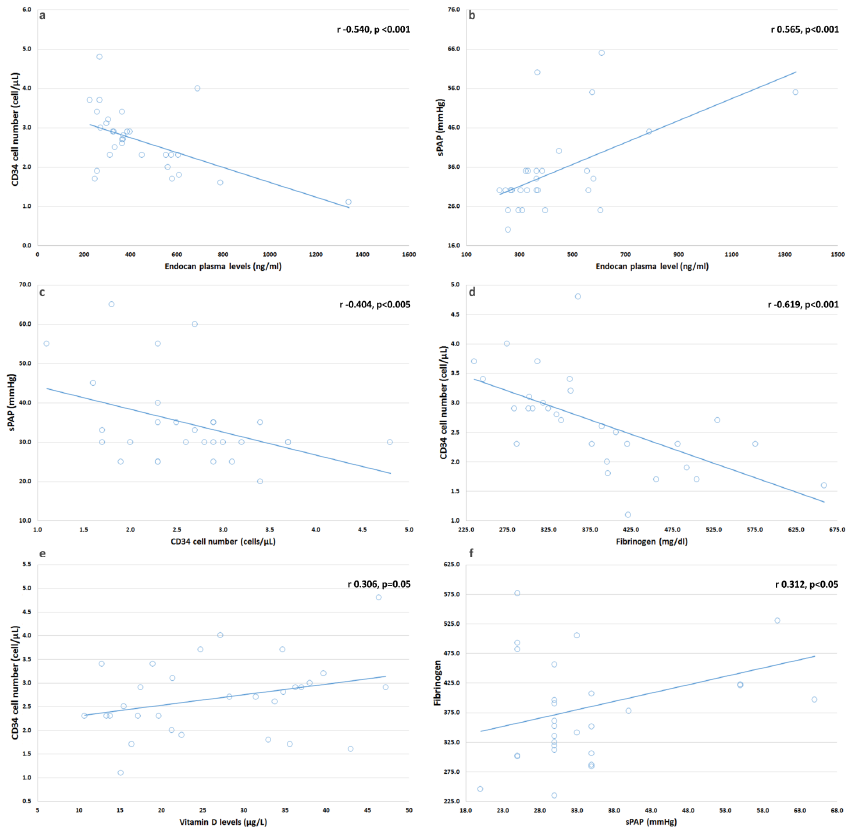
Figure 2. Spearman’s correlation between CD34+ and endocan ( a ); sPAP and endocan ( b ); sPAP and CD34+ ( c ); CD34+ and fibrinogen ( d ); CD34+ and Vitamin D ( e ); sPAP and fibrinogen ( f ).